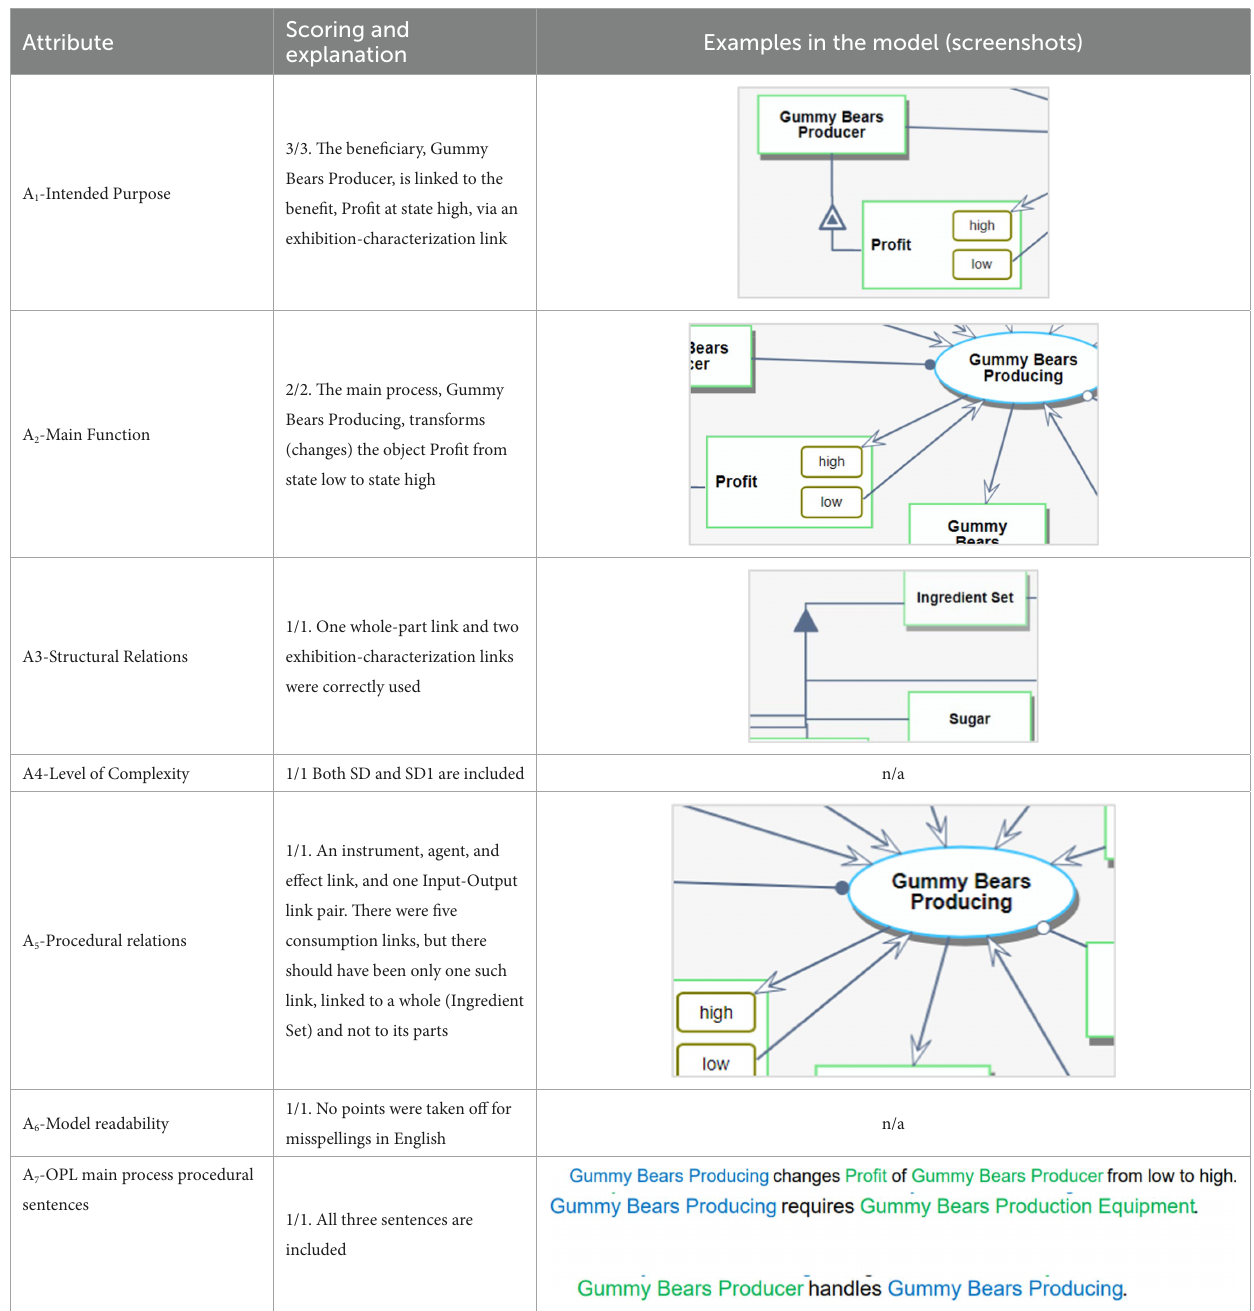
TABLE 7 Scores and explanations for the OPM model created by Eli. Attribute